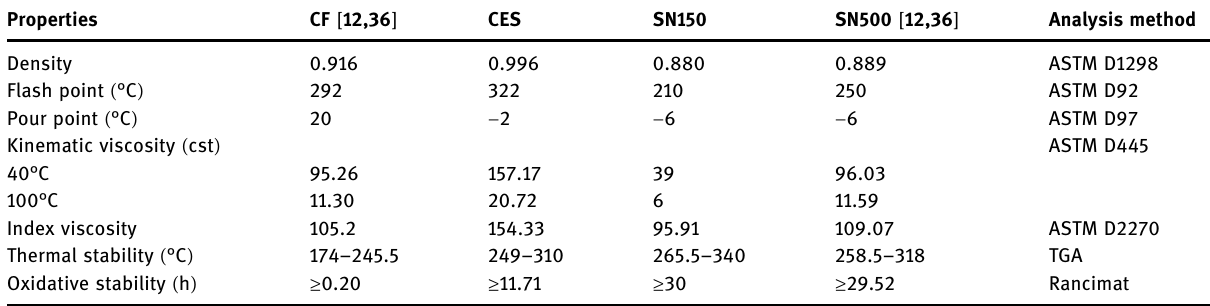
Table 1: The basic properties of cat fi sh oil material ( CF ) , CES product, and mineral base oils SN150 and SN500 ( SN150, SN500 )